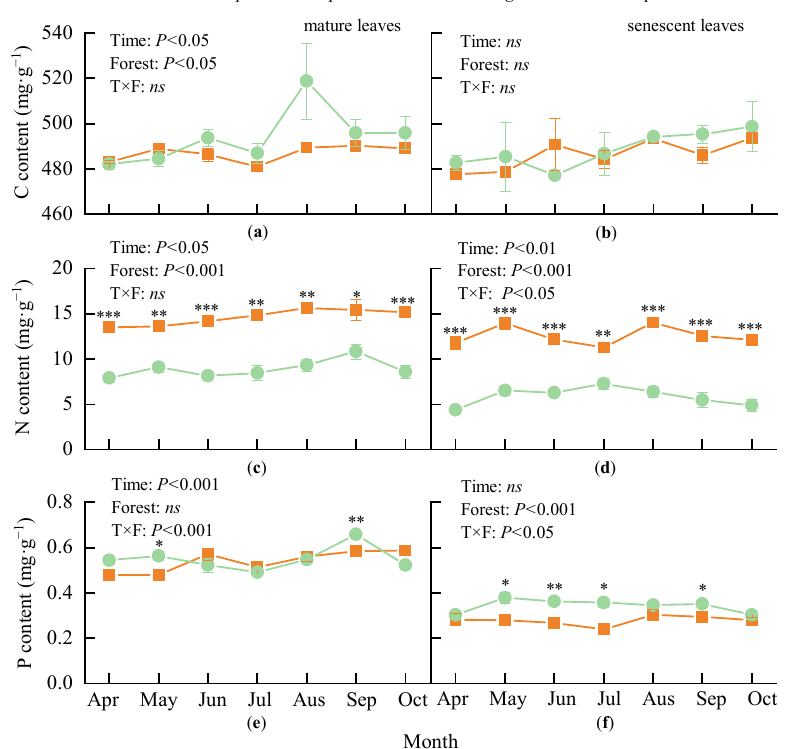
Figure 2. C, N and P contents in mature ( a , c , e ) and senescent leaves ( b , d , f ). Each scatter represents the average value of the three replicates ( n = 3). Error bars represent standard errors (SE). The p values show the results from repeated measures ANOVA testing for the effect of forest type over time. ns : not significant. Asterisks denote significant differences between forest types: * p < 0.05, ** p < 0.01, *** p < 0.001.